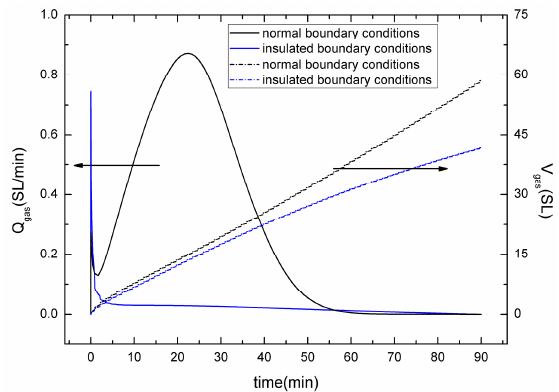
Figure 11. Gas generation rate and cumulative gas production time evolution for the normal boundary conditions and insulated boundary conditions. conditions and insulated boundary